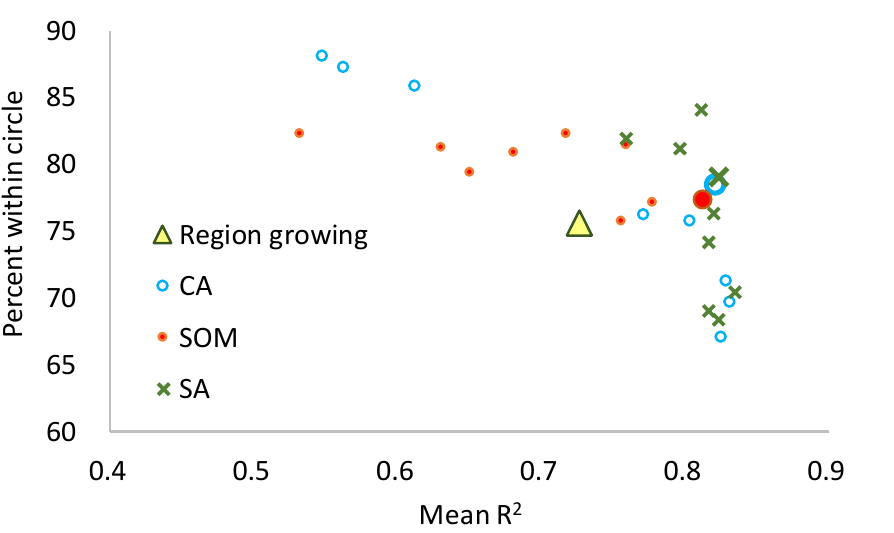
Figure 6. Relationship between the mean R 2 of the LiDAR metrics ( HP95 , AH5 , IV ) and a shape metric when CA, SOM, and SA were used with different parameter values. Larger markers show the results for those segmentations that were obtained with parameters selected for further analyses.